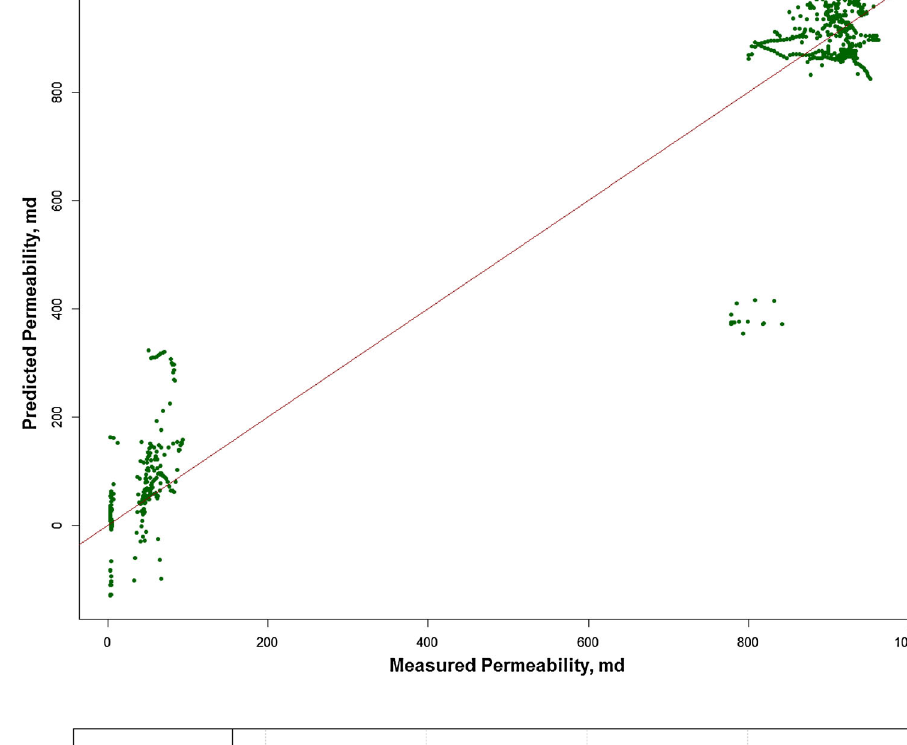
Fig. 10 Matching between the entire vertical predicted and observed core permeability by MLR